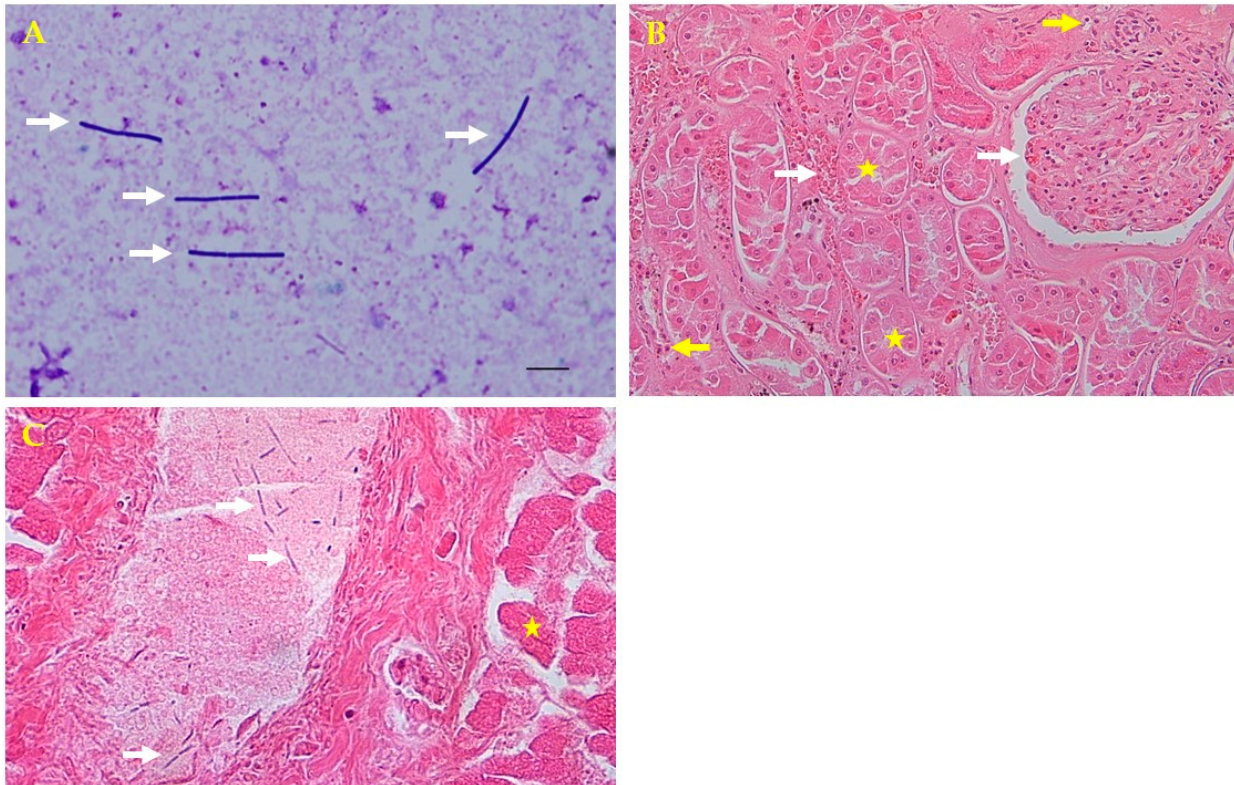
Figure 2. Microscopic and histopathologic findings. ( A ) Direct smear from the liver parenchyma showing rod-shaped bacteria colonies by Giemsa staining (white arrows; 1000 × ). ( B ) Kidney tubular necrosis (yellow stars) and glomerular and intertubular congestion (white arrows) with inflammatory cells (yellow arrows) by hematoxylin and eosin (H&E) staining (200 × ). ( C ) Thread-like bacteria (white arrows) in the portal vein and hepatocellular necrosis in the liver (yellow star) by H&E staining (400 × ).